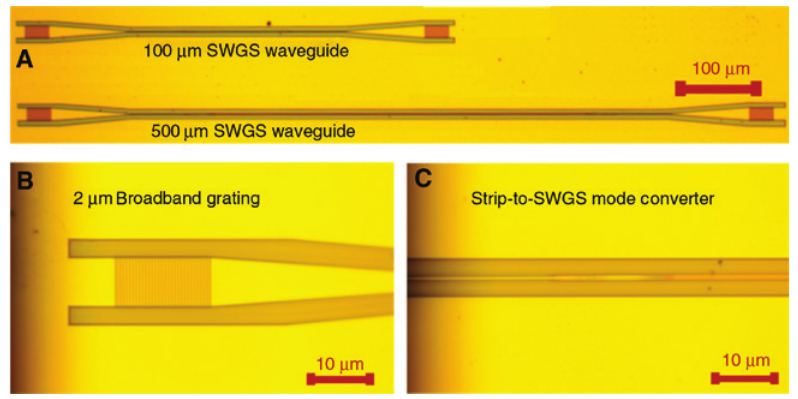
Figure 7: Measured microscope image of the fabricated devices. (A) Optical microscope image of the fabricated silicon-based 100- μ m- and 500- μ m-long SWGS waveguides. (B) Zoom-in view of 2- μ m broad- band grating. (C) Zoom-in view of strip-to-SWGS mode converter.